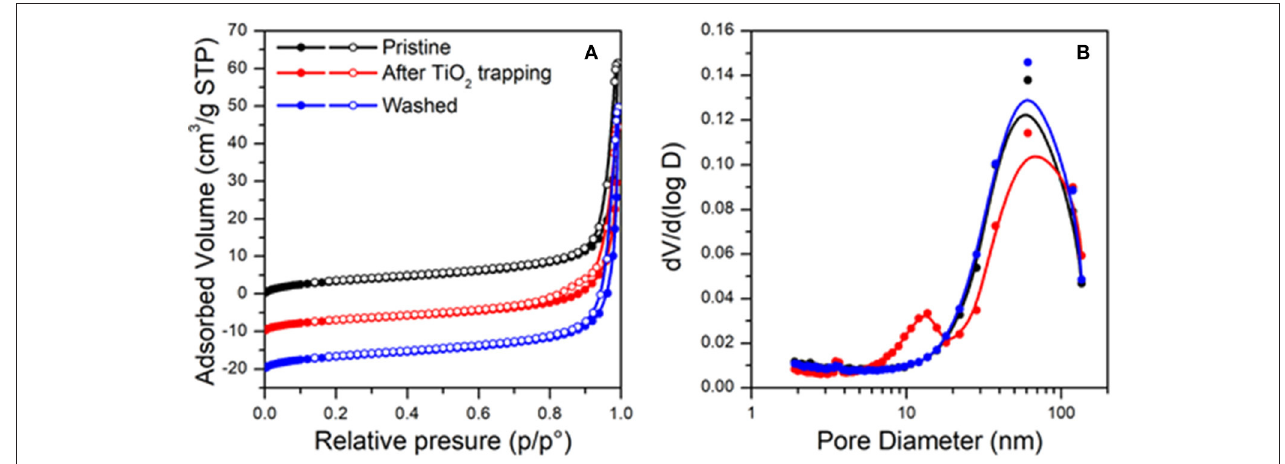
FIGURE 9 | Result from N 2 physisorption at the liquid temperature: physisorption isotherms (A) and BJH pore size distributions calculated from the desorption branches (B) .